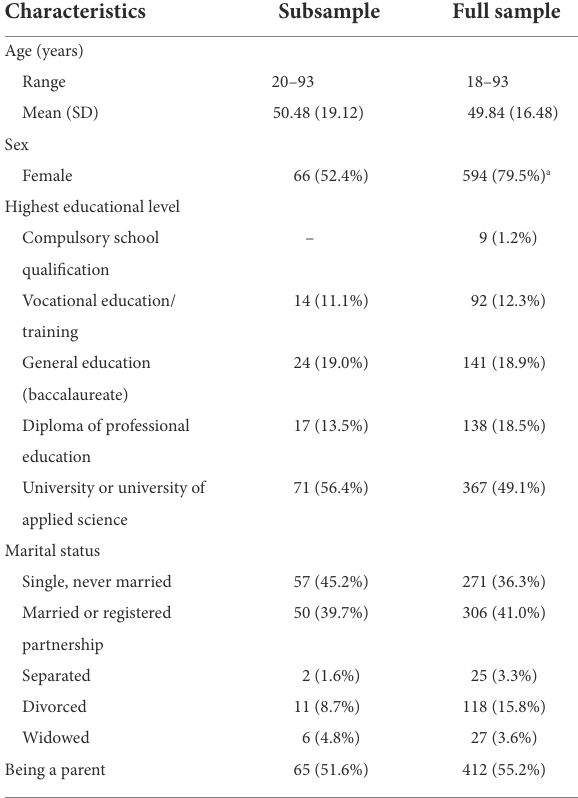
TABLE 1 Sociodemographic characteristics of